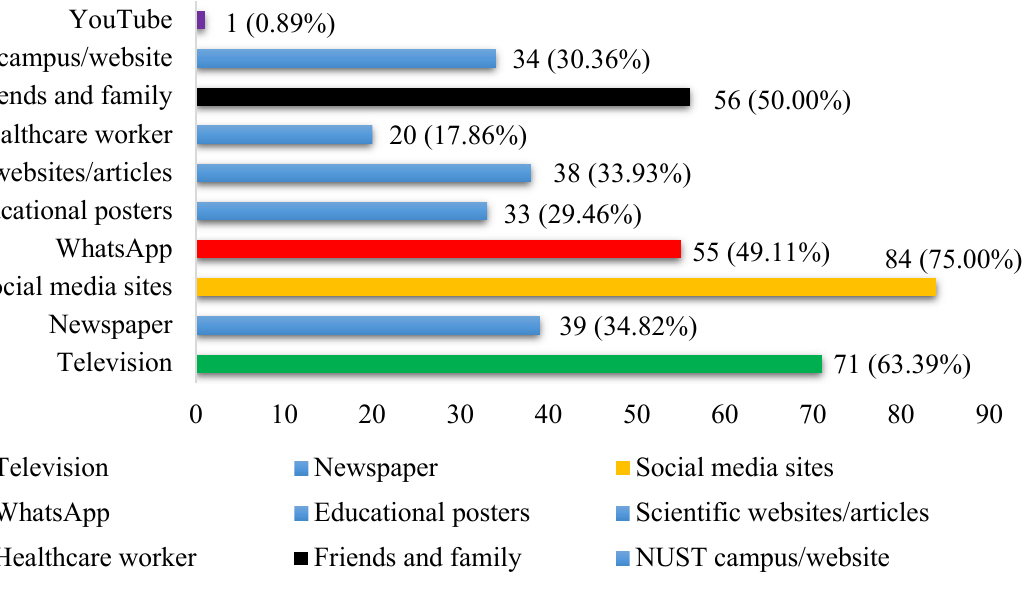
Figure 1. Faculties in which students have enrolled.